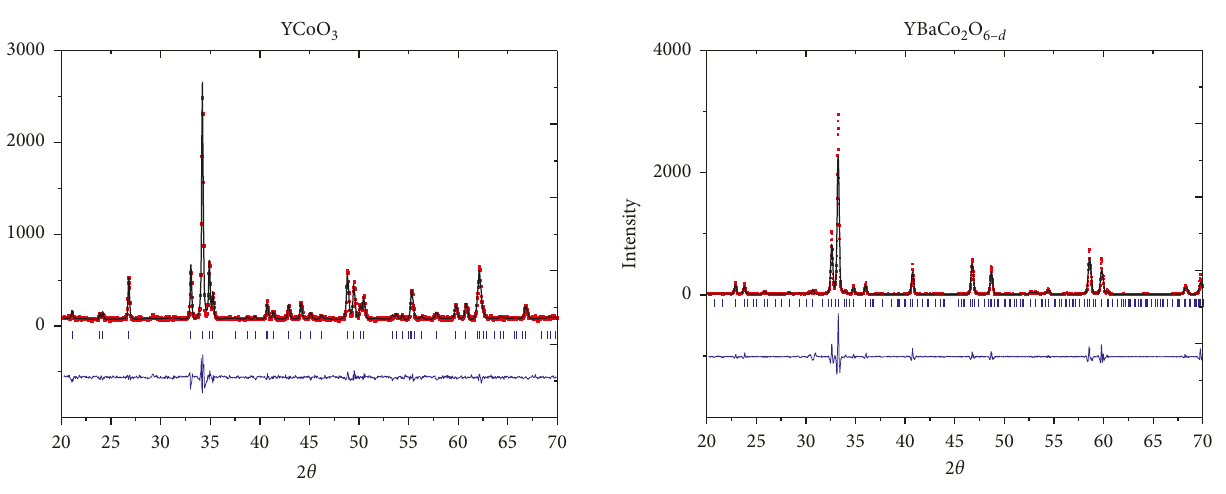
Figure 1: X-ray diffraction pattern and its matching refinement plot of YCoO 3 : observed X-ray diffraction intensity (points) and calculated curve (line). The bottom curve is the difference of patterns, y obs y cal , and the small bars indicate the angular posi- tions of the allowed Bragg reflections. −